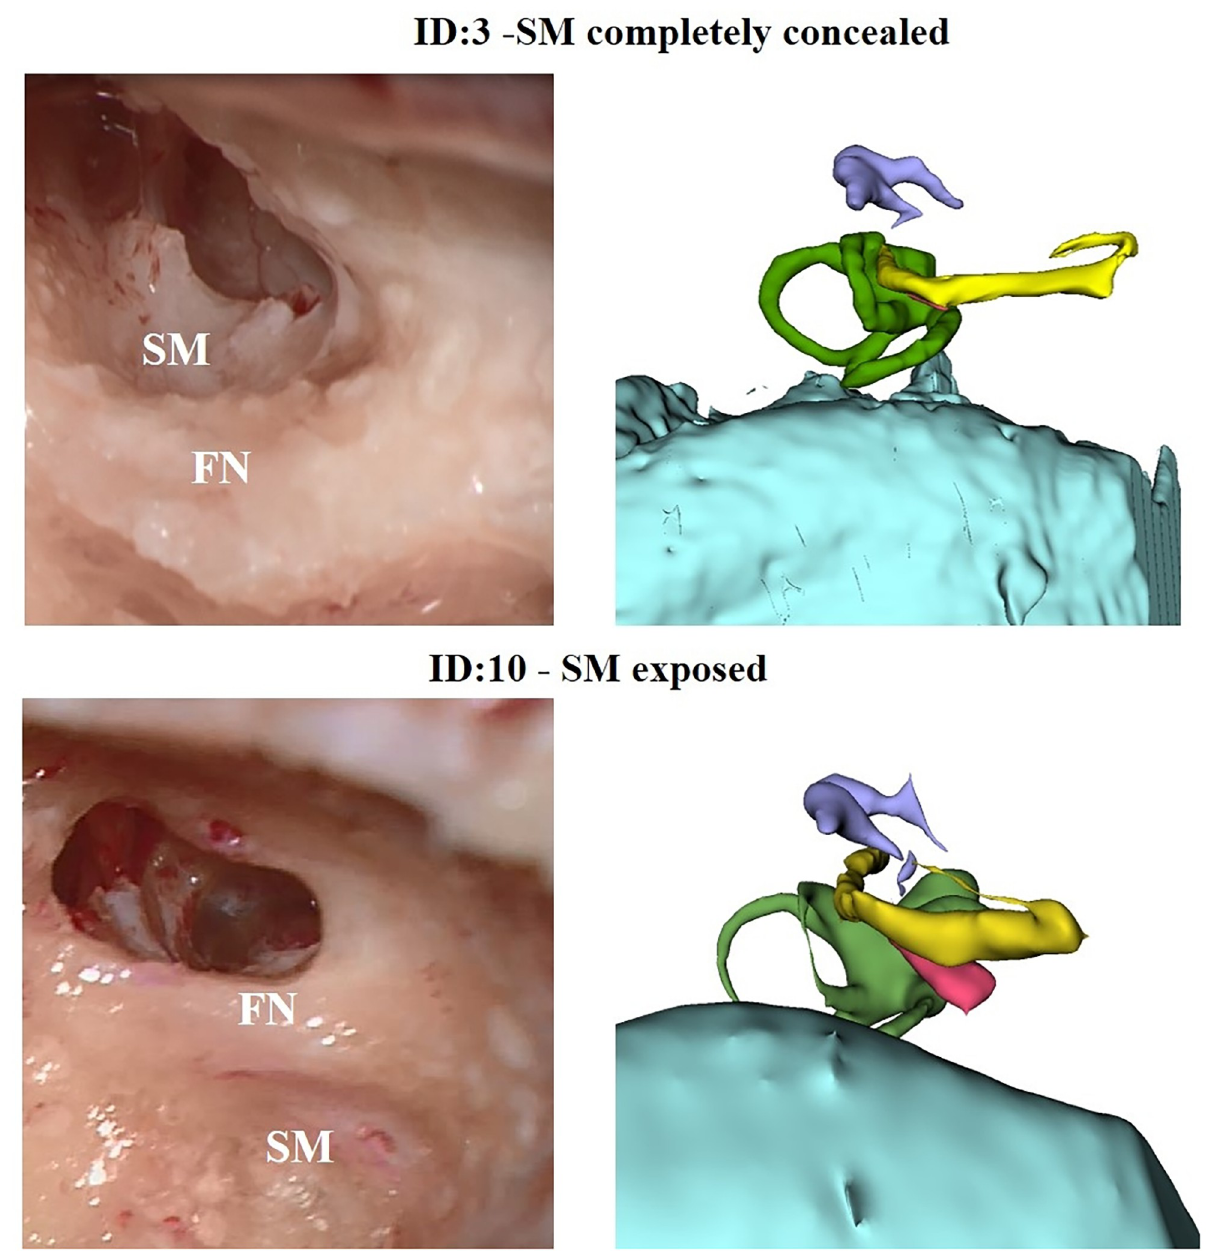
Fig 3. Comparison between two different SM configurations leading to two different surgical accesses, right ear. Top: case #3 categorized as SM completely concealed (according to [19]). Bottom: case #10 categorized as SM exposed (according to [19]). Surgical microscopic view of the access performed from anterior the FN (left) and 3-D reconstruction (right). SM: stapedius muscle, FN: facial nerve.